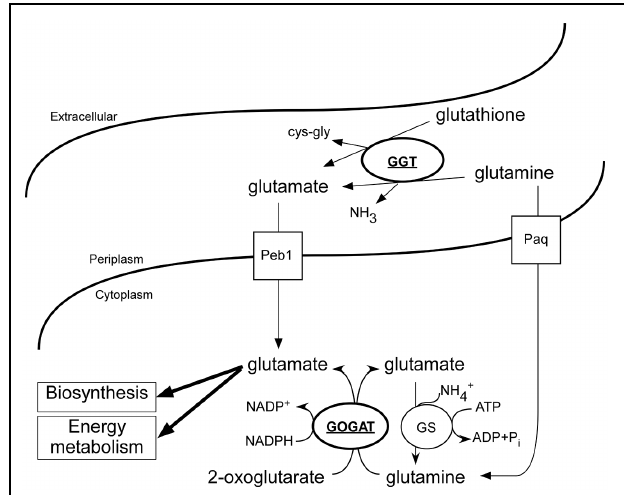
FIGURE 6 | Overview of the C. jejuni glutamate generating enzymes and involved transport systems. Under low oxygen conditions in the presence of additional electron acceptors, RacR is activated and enhances the production of GGT and GOGAT (bold and underlined). Glutamine and glutathione are converted to glutamate in the periplasm by GGT; glutamate is consequently imported and used as carbon/energy source and anabolic precursor. Independent of GGT, glutamine can be imported and converted to glutamate by GOGAT, however, this process is dependent on the presence of additional carbon/energy